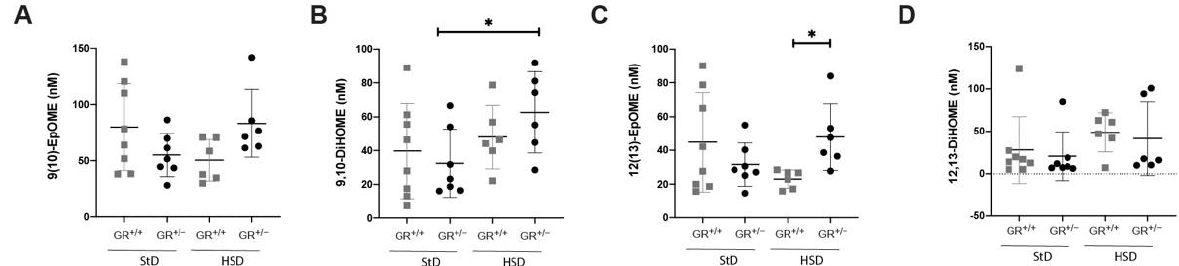
Figure 7. Fatty acid disturbances in linoleic acid pathway in GR +/ − rats. Metabolites of ( A ) 9,10-epoxyoctadecenoic acid (EpOME), ( B ) 9,10- dihydroxyoctadecenoic acid (DiHoME), ( C ) 12,13-EpOME and ( D ) 12,13-DiHoME measured in plasma of GR +/+ (StD n = 8, HSD n = 6) and GR +/ − rats (StD n = 7, HSD n = 6) under standard or high salt diet. Values are indicated as mean ± SEM, and data were evaluated by unpaired two-tailed t test and differences assessed at * p < 0.05.